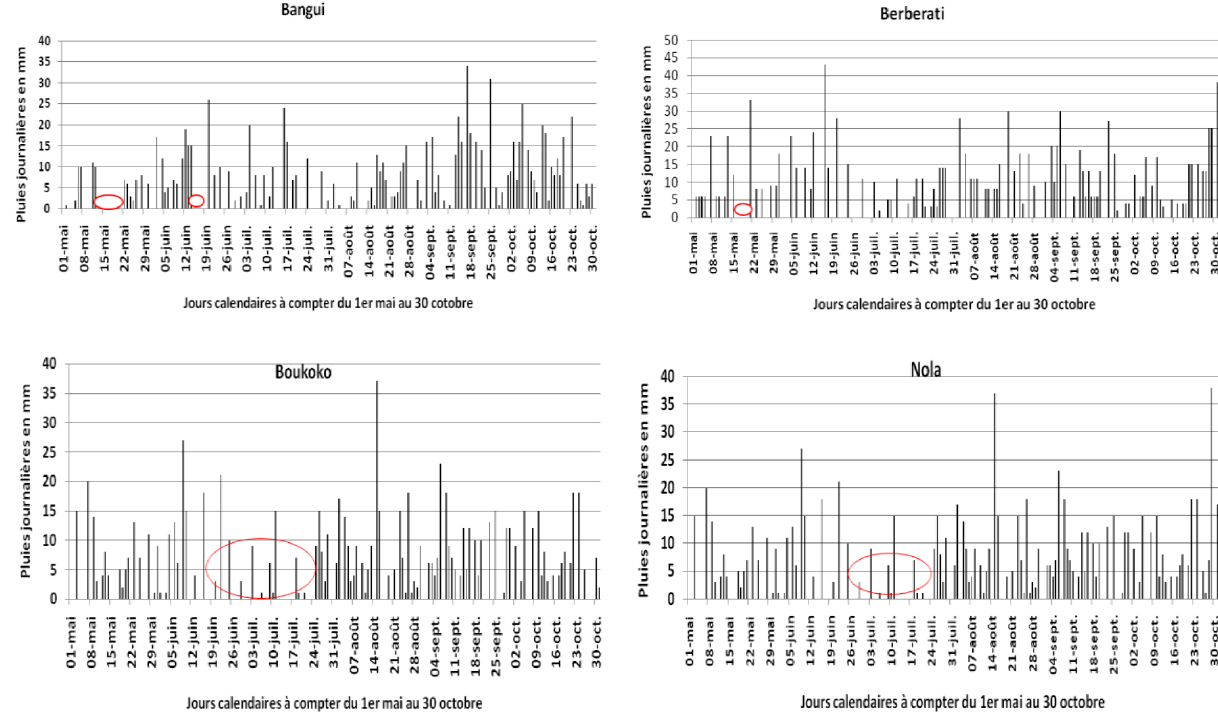
Figure 5. Variation intra-saisonnière des précipitations journalières dans les quatre stations représentatives de la zone d’étude à compter du 1 mai au 30 octobre